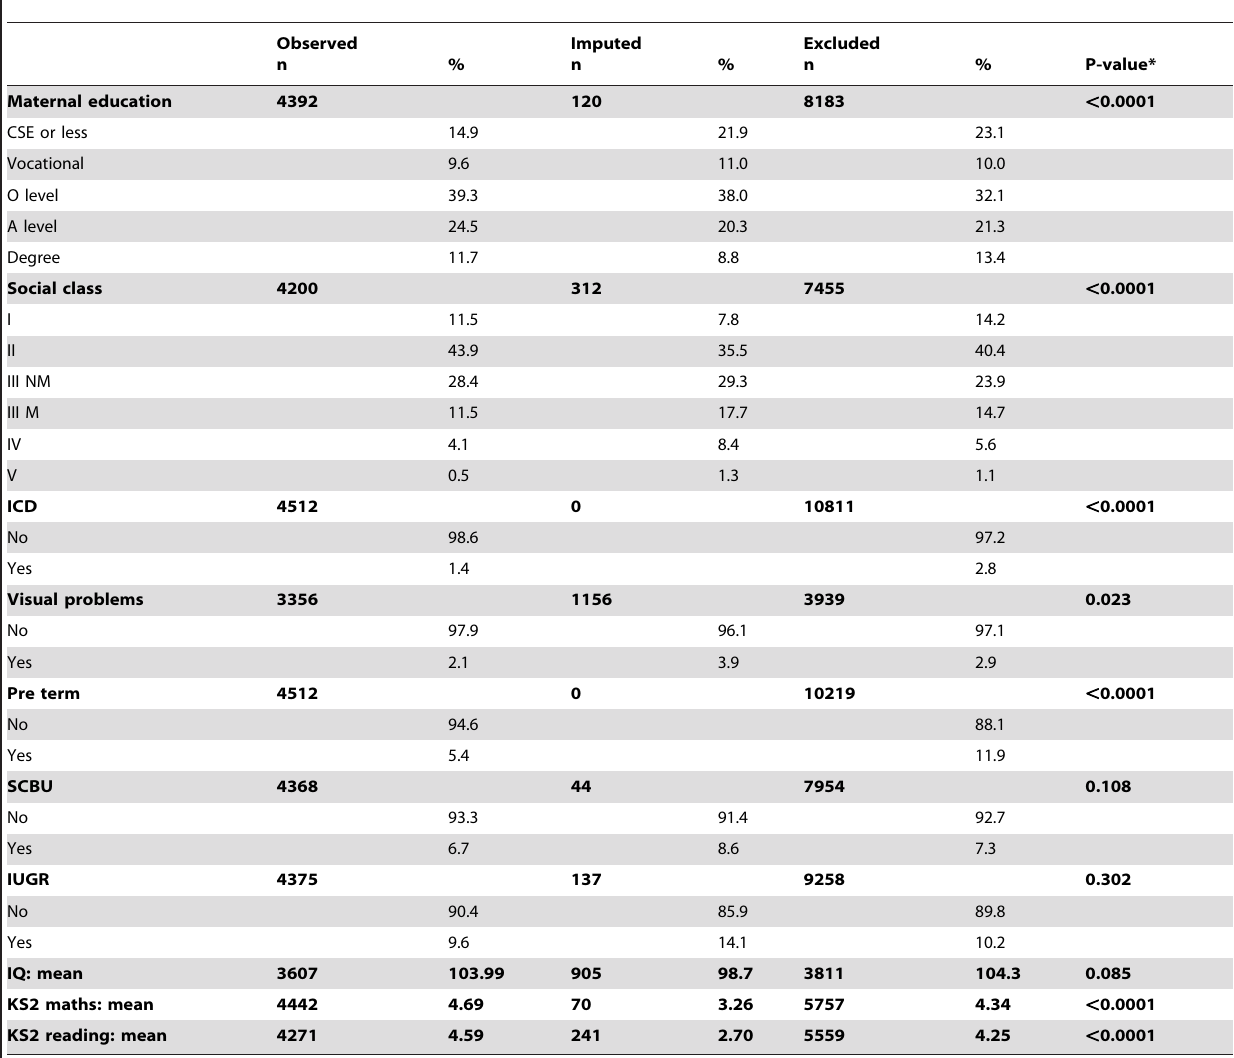
Table 2. Comparison of the observed and imputed data for those with Visual perception scores and KS3 Maths and English scores (n=4512) and for children excluded from the